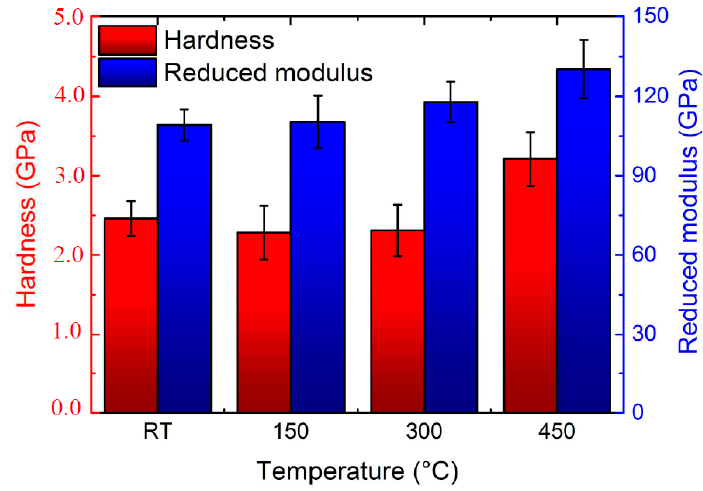
Figure 3. Hardness and reduced modulus of the Ti films deposited at different temperatures.